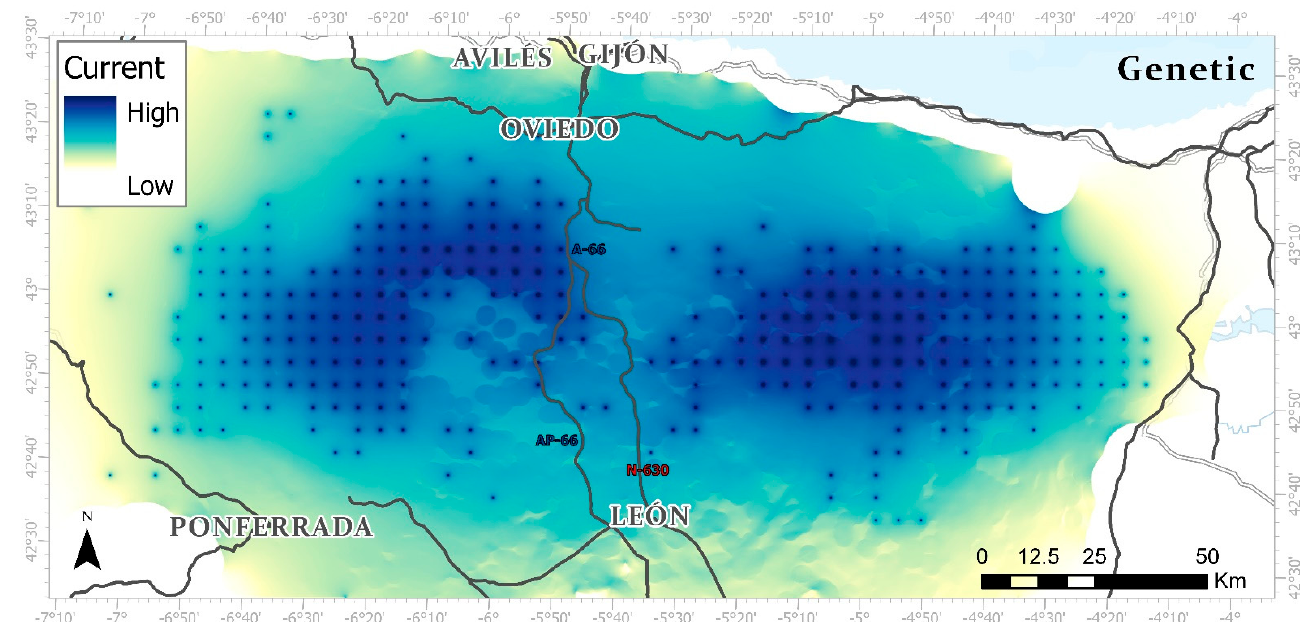
Figure A4. Links based on the least-cost modeling methodology for the genetic-multiplicative resistance surface.